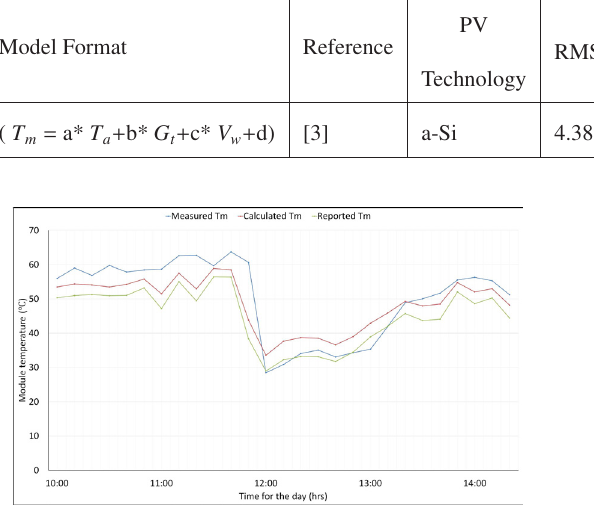
Figure 2. Module temperature graph for monsoon day 12 th July of a-Si PV technology.